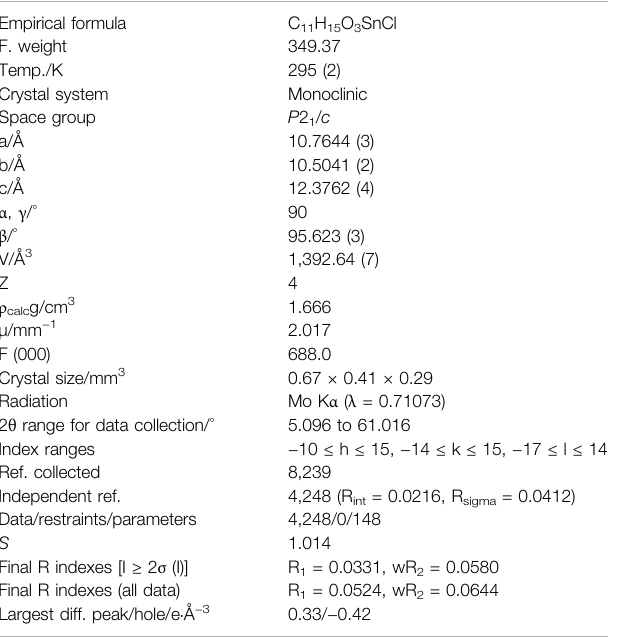
TABLE 1 | Important crystallographic parameters of 4 . Empirical formula